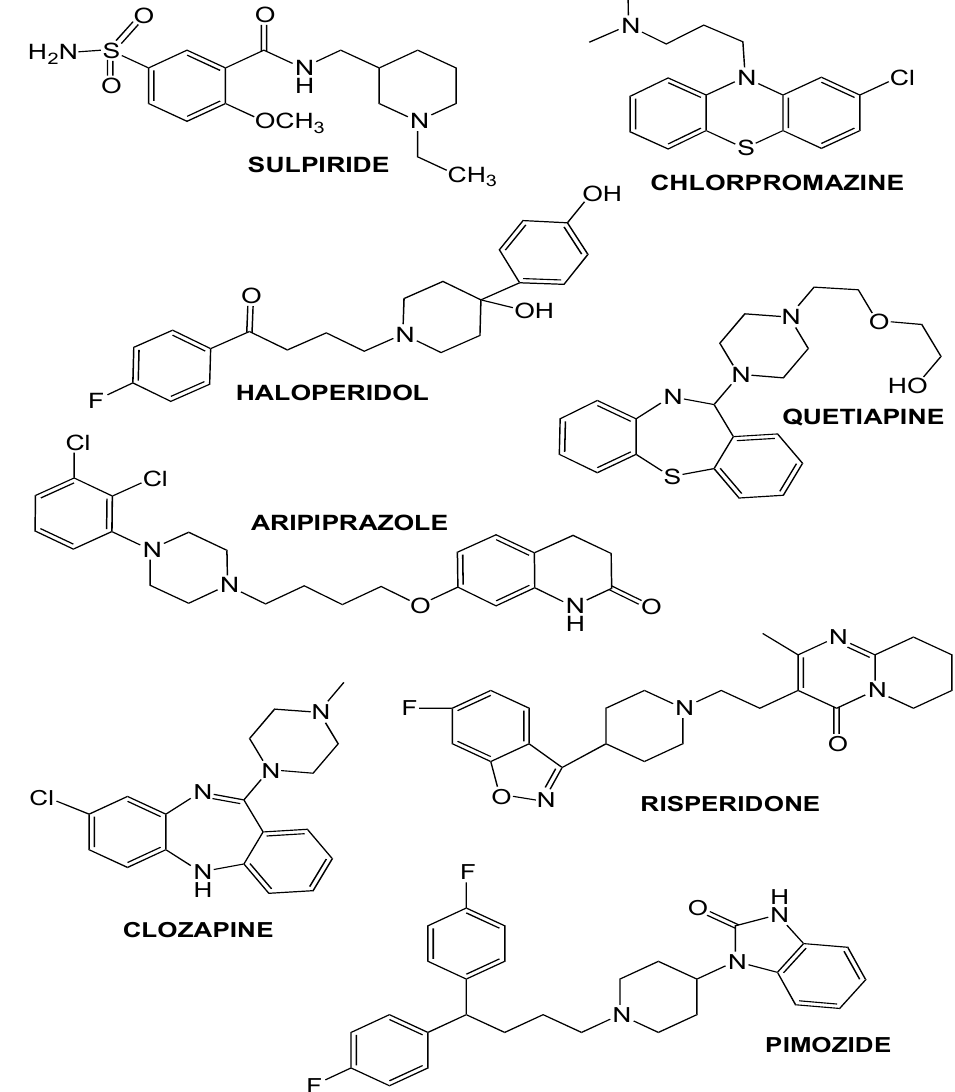
Figure 3. Representative chemical structures of both typical and atypical antipsychotics. Table 2. Representative typical and atypical antipsychotic drugs with their potential mechanism of action.